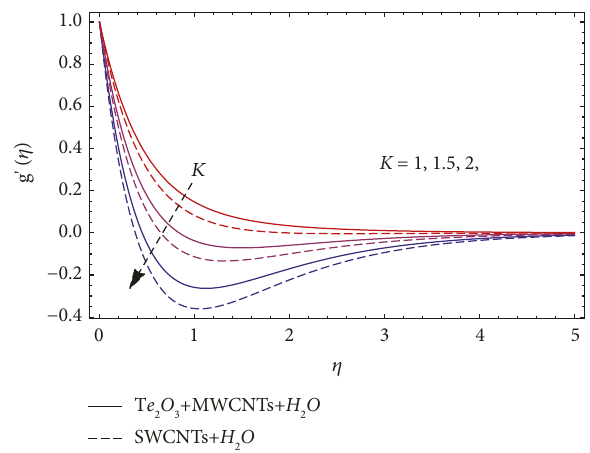
Figure 6: Influence of couple stress parameter on velocity profile in y direction.